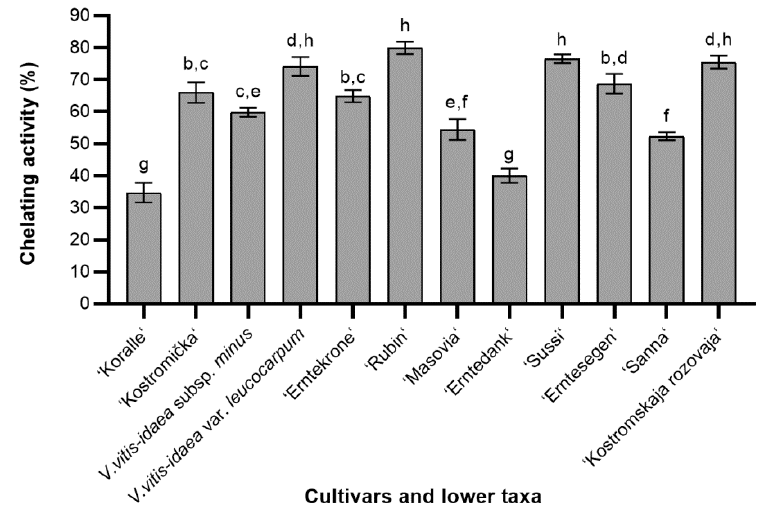
Figure 3. The chelating activity of different cultivars and lower taxa of lingonberry leaves extracts; bars without the same letters (a, b, c, d, e, f, g, h) indicate statistically significant differences between the means ( p <